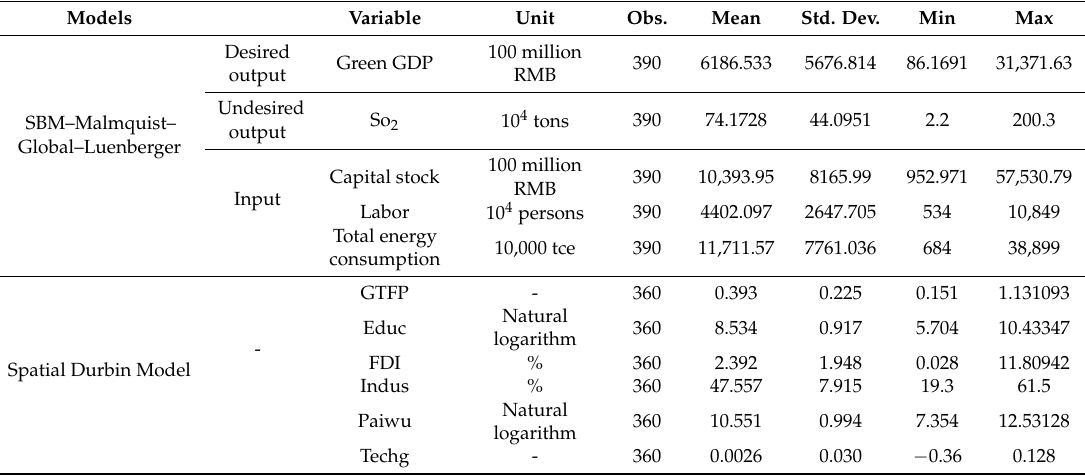
Table 1. Summary of variables.